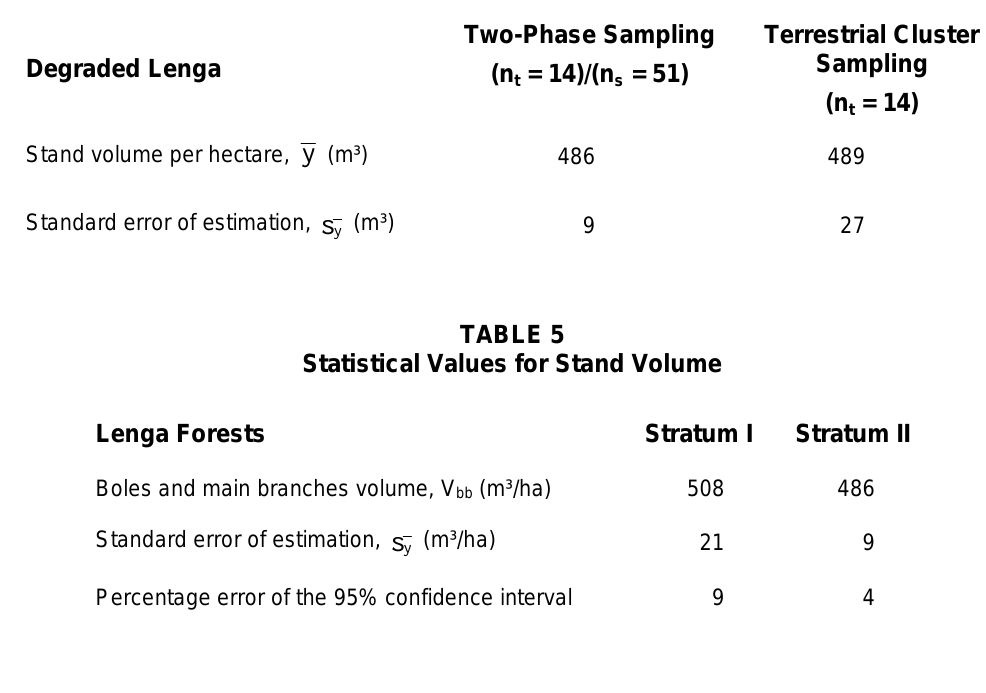
Comparison of the Stand Volume Estimate Based on Two-Phase Random Sampling and Terrestrial-Only Cluster Sampling in Lenga Stratum 2